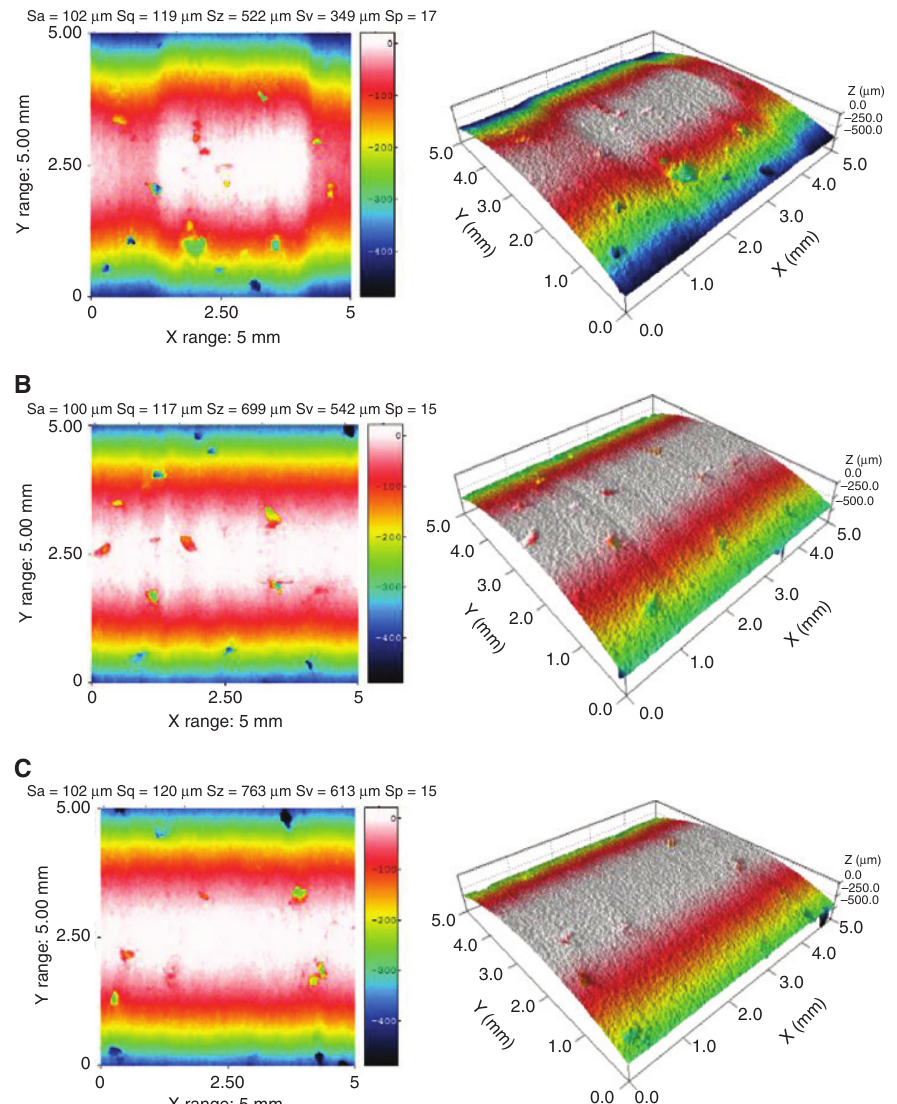
Figure 8: Visualization of the machined surfaces at (A) 200 rpm, (B) 400 rpm, and (C) 600 rpm (MicroProf FRT optical